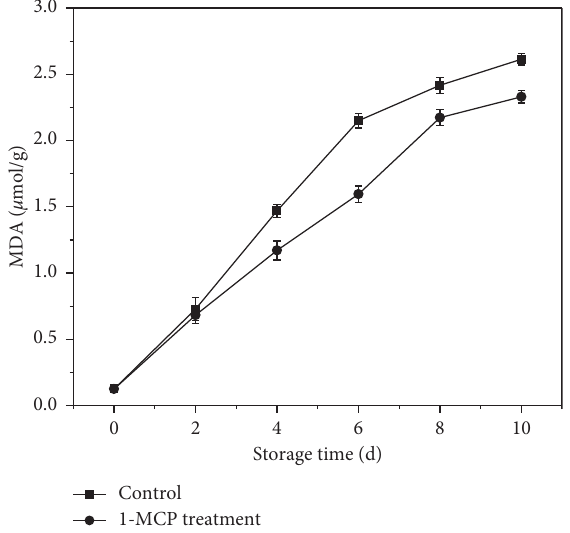
Figure 4: Effects of 1-MCP treatment on MDA of mango fruit during storage at 25 ° C. The data are the means of triplicates ± - standard